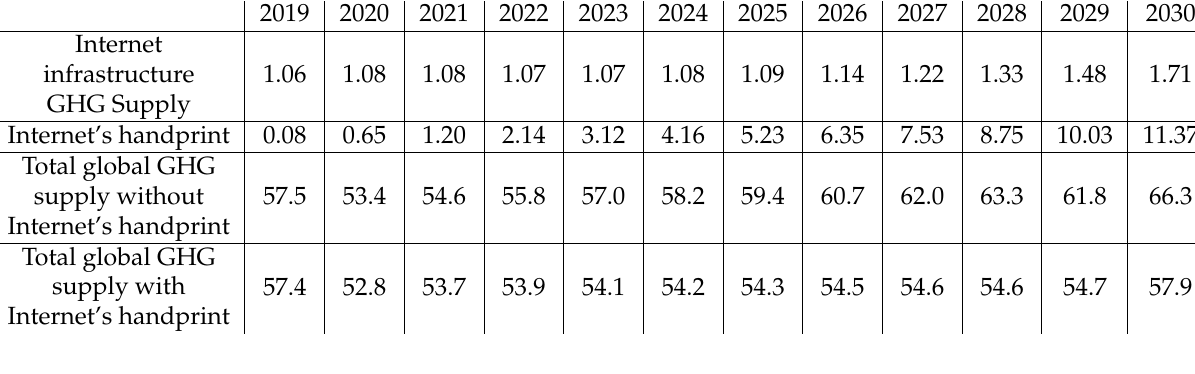
Table 19. Effect of Internet handprint on global GHG supply from 2019 to 2030.